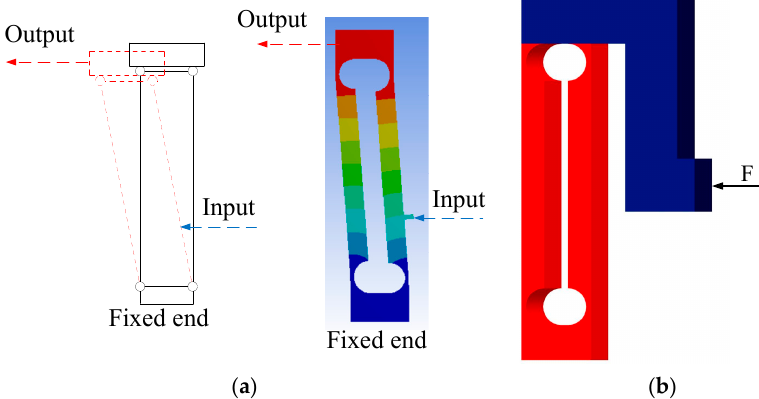
Figure 4. Amplification principle of the parallelogram mechanism: ( a ) traditional parallelogram mechanism and ( b ) a new type of parallelogram mechanism.